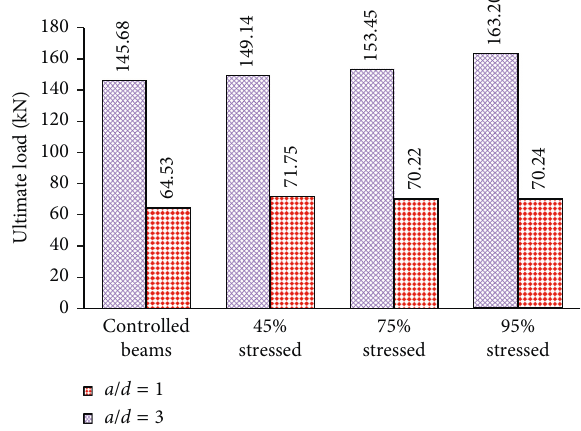
Figure 8: Comparison of ultimate loads of shear-designed beams tested at a / d ratios 1 and